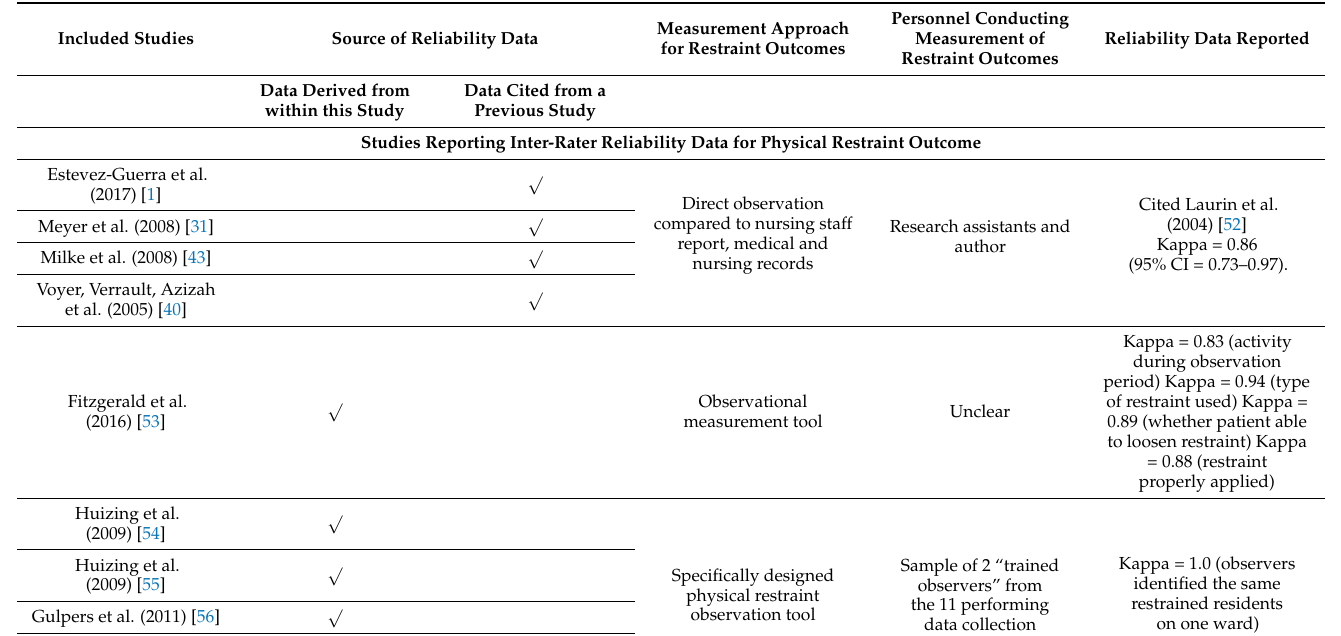
Table 1. Inter-rater reliability data reported in included